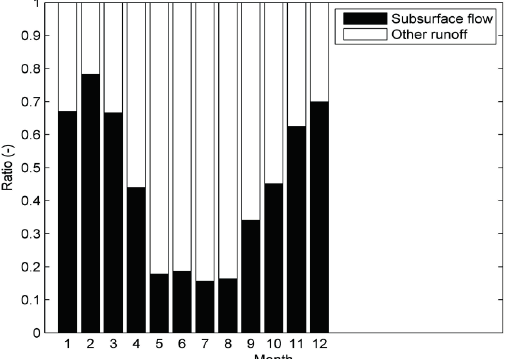
Fig. 5 The monthly ratio of the subsurface flow to the streamflow from Arnold separation